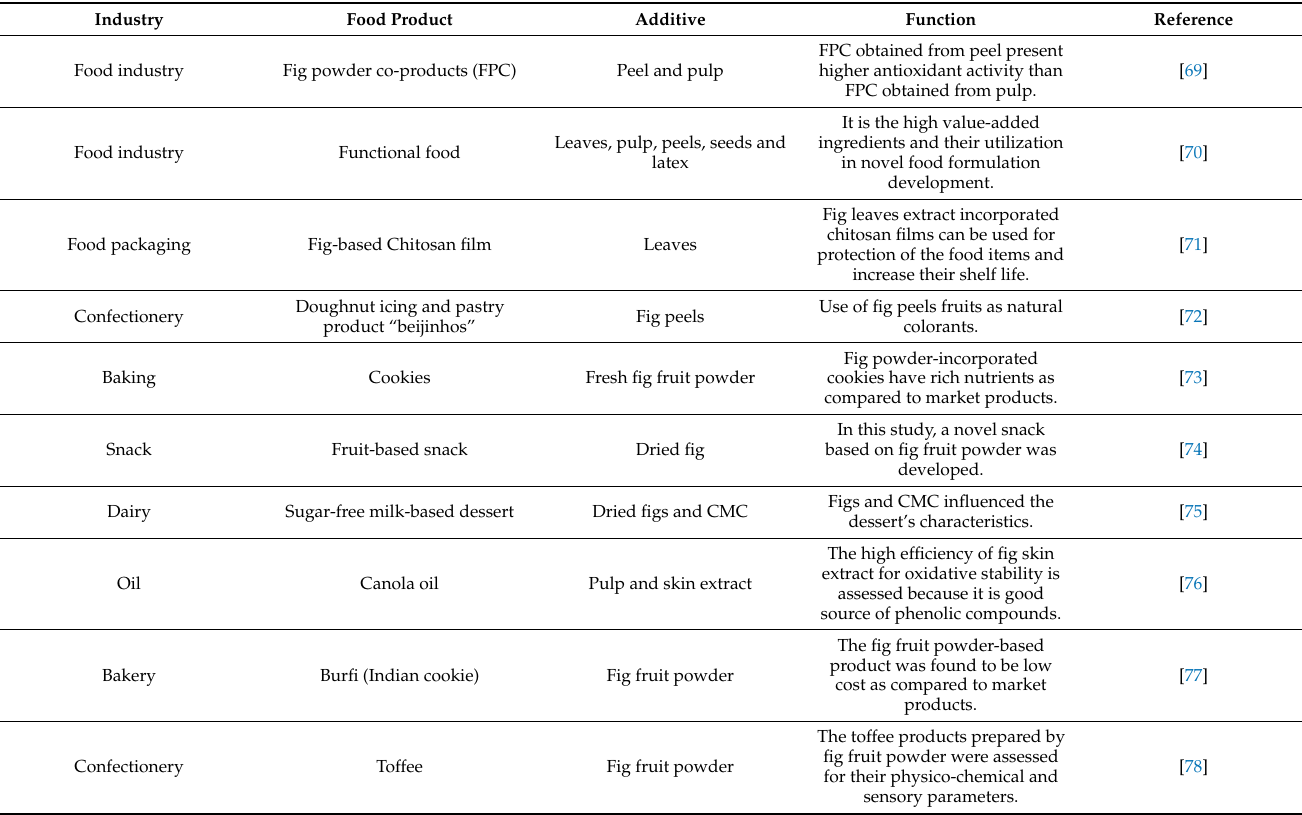
Table 2. Value addition role of fig in food industries.